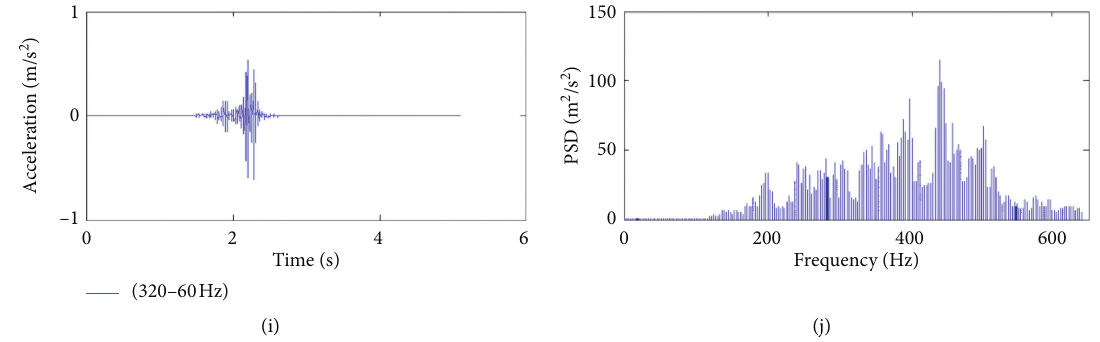
Figure 10: Acceleration and power spectrum curves of reconstructed signals on the fifth frequency bands at the 50cm depth testing points: (a) acceleration curve of the first frequency band, (b) power spectrum curve of the first frequency band, (c) acceleration curve of the second frequency band, (d) power spectrum curve of the second frequency band, (e) acceleration curve of the third frequency band, (f) power spectrum curve of the third frequency band, (g) acceleration curve of the fourth frequency band, (h) power spectrum curve of the fourth frequency band, (i) acceleration curve of the fifth frequency band, and (j) power spectrum curve of the fifth frequency band.